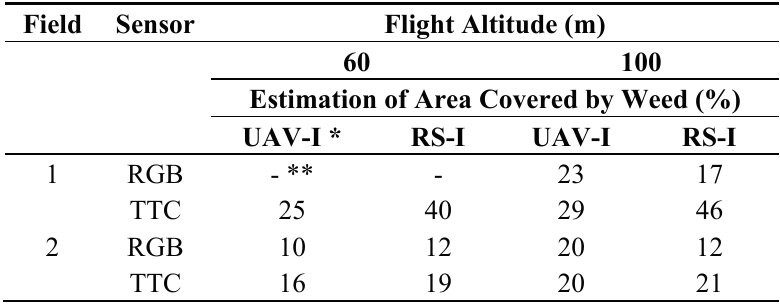
Table 4. Percentage of area covered by weed